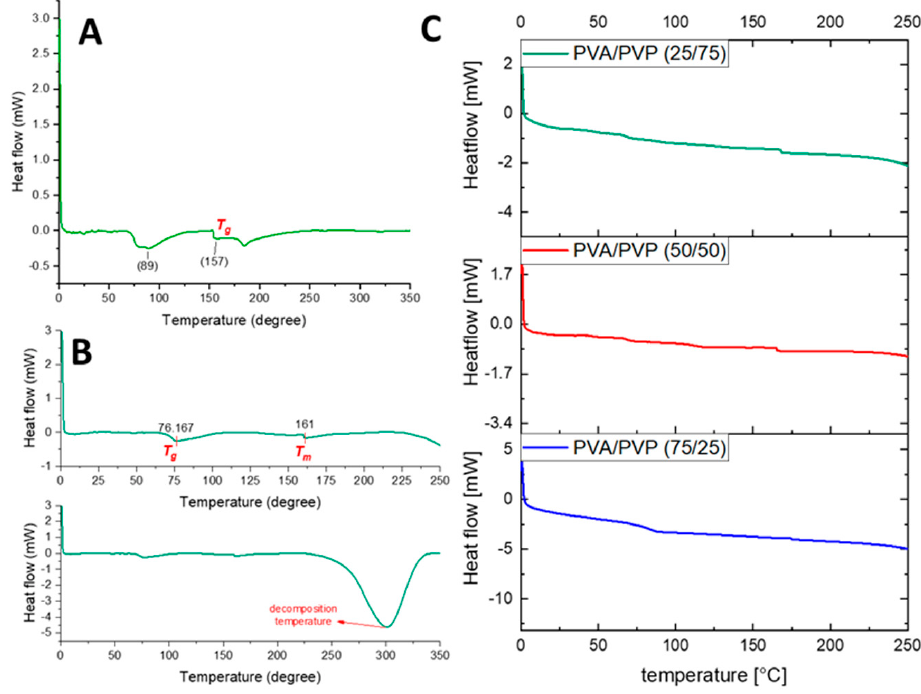
Figure 4. DSC thermograms of ( A ) PVP, ( B ) PVA, and ( C ) PVA/PVP blend nanofibers.